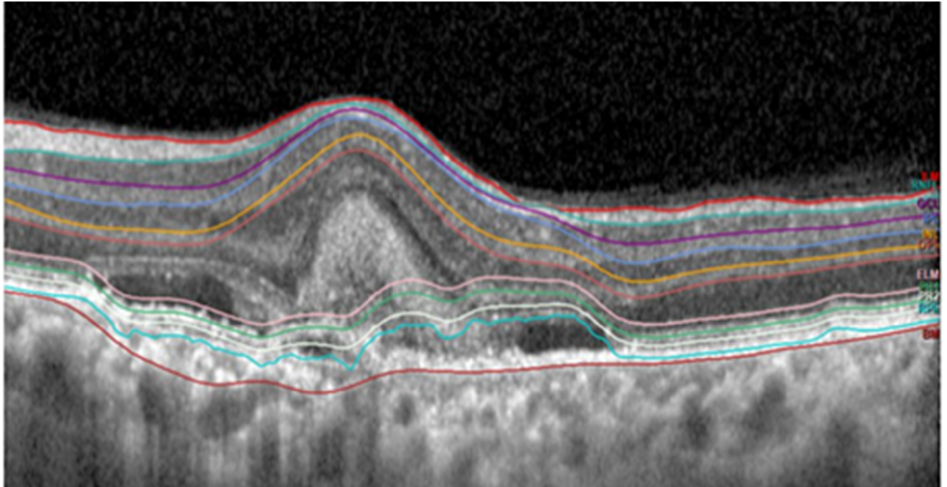
Figure 14. False segmentation of subretinal layers.